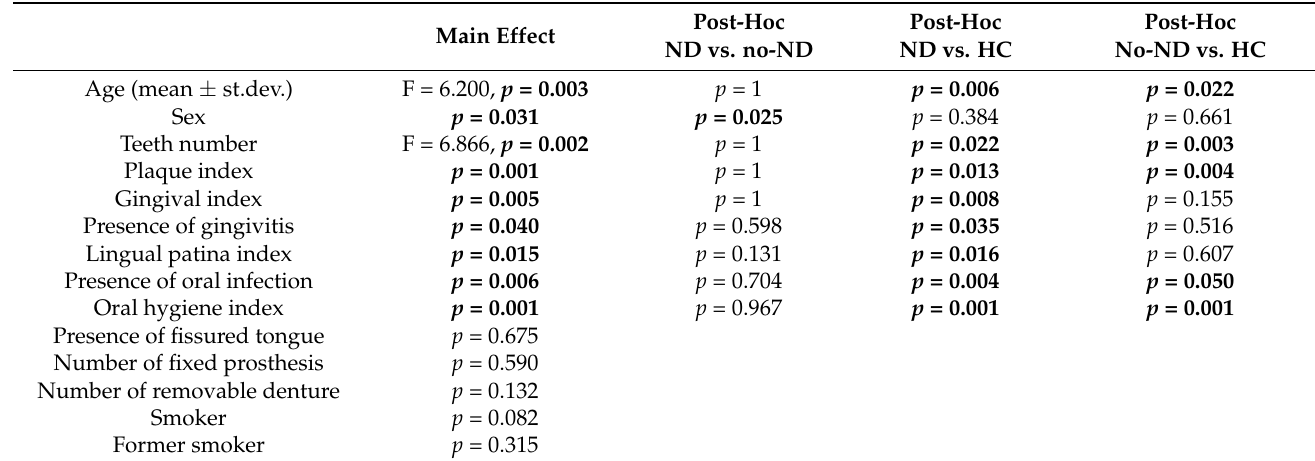
Table 2. Statistical results of the comparison of demographic characteristics and oral indices among groups included in the study. Significant results are highlighted in bold.